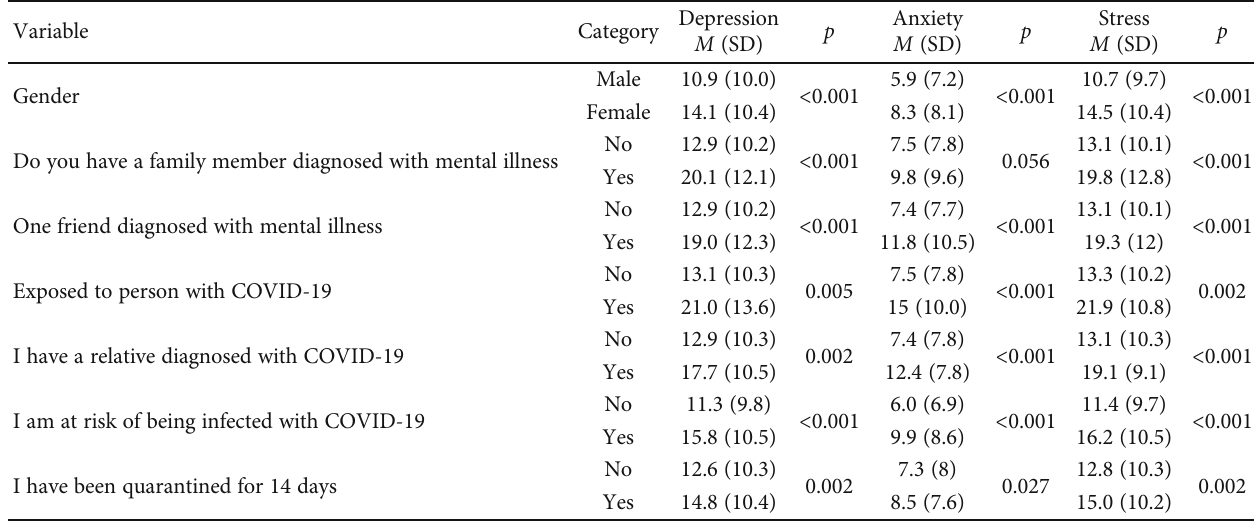
Table 3: Bivariate analysis of depression, anxiety, and stress.